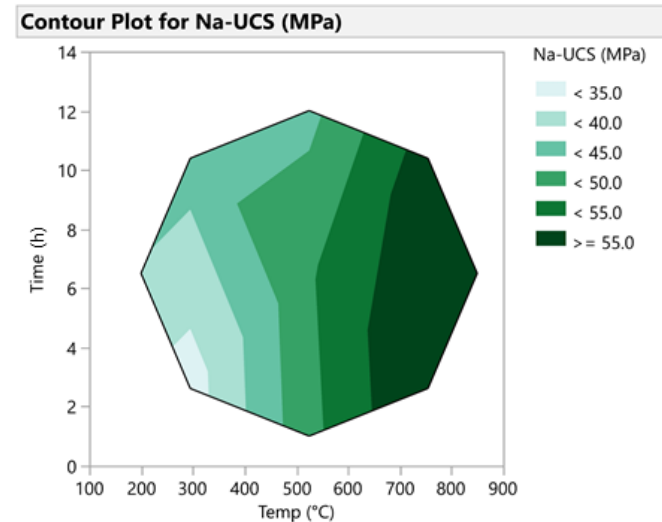
Figure 8. Contour plot for Na-based geopolymer cement.